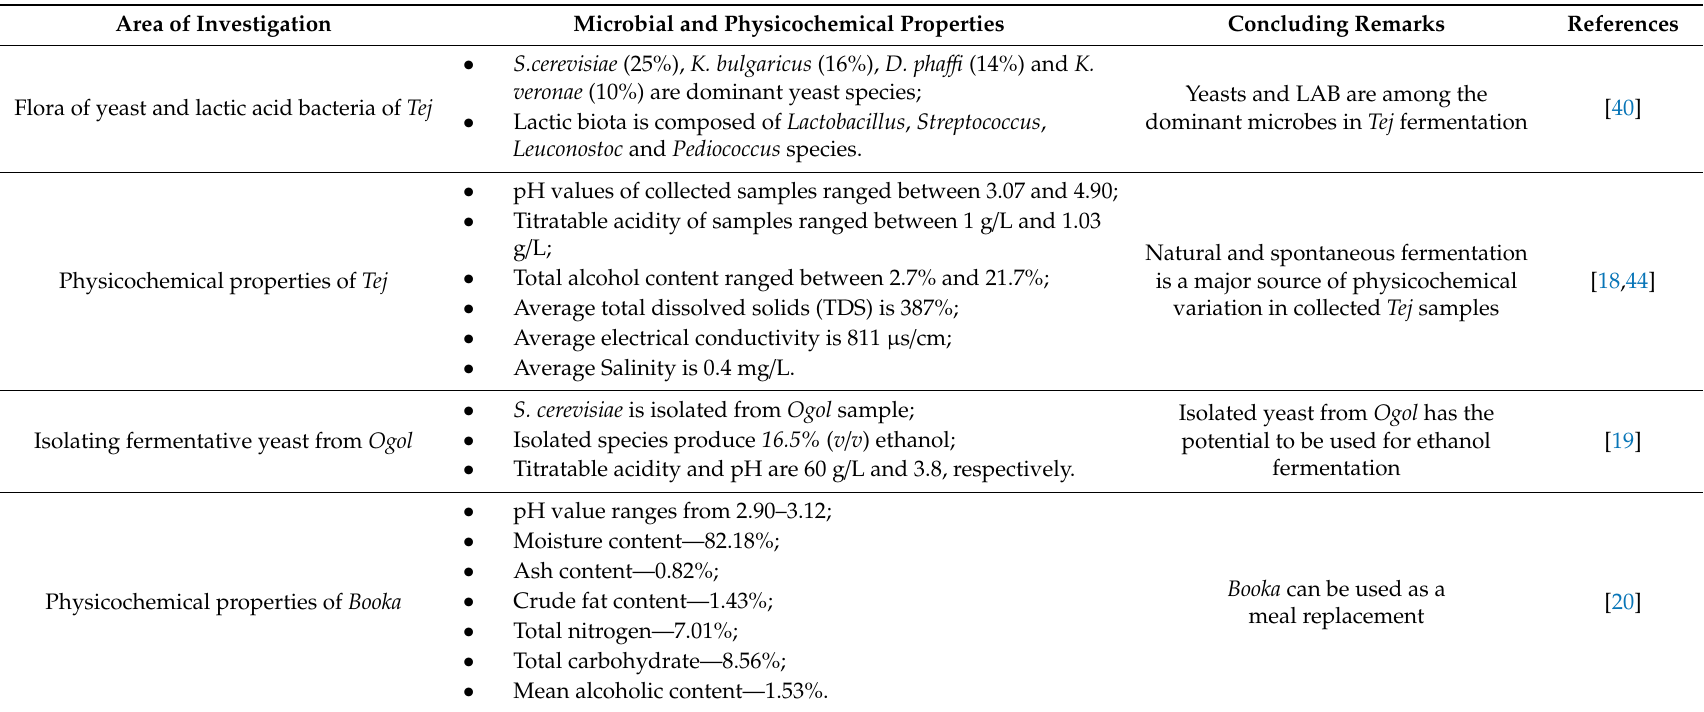
Table 4. Physicochemical and microbiological properties of Tej , Ogol and